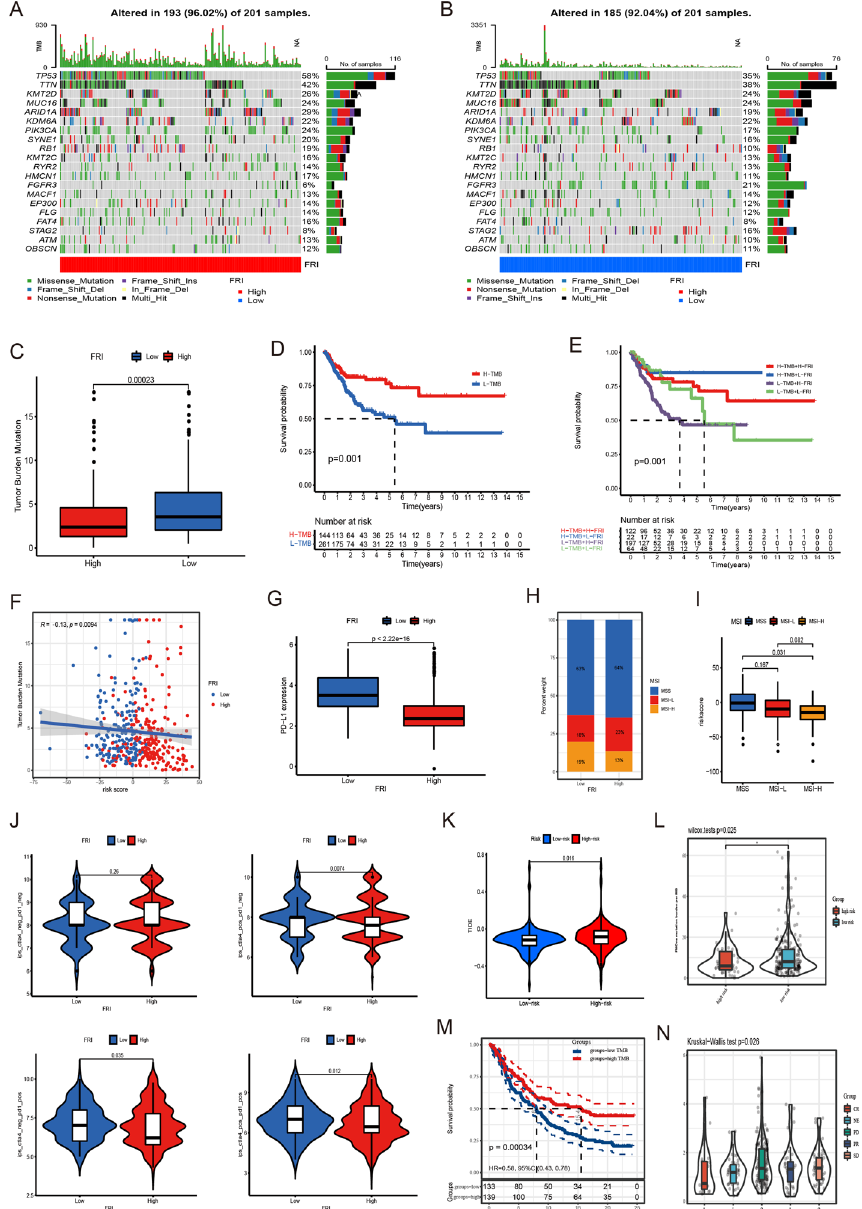
Fig. 8 Characteristics of 5‑lncRNA signature in TCGA molecular subtypes and relationship with tumor somatic mutation and MSI. A , B The waterfall plot of tumor somatic mutation. C Difference of TMB. D Survival analyses in TCGA cohort. E Survival analyses stratified by both FRI and TMB. F Correlation between FRI level and TMB in TCGA cohort. G Difference in PD‑L1 expression. H The proportion of MSI subtype. I Differences of FRI among three MSI status in TCGA cohort. J The association between IPS and FRI. K Difference of TIDE score. L Differences of TMB in IMvigor210 cohort. M Survival analyses by median TMB in IMvigor210 cohort. N Differences of FRI among distinct immunotherapy response phenotypes in IMvigor210